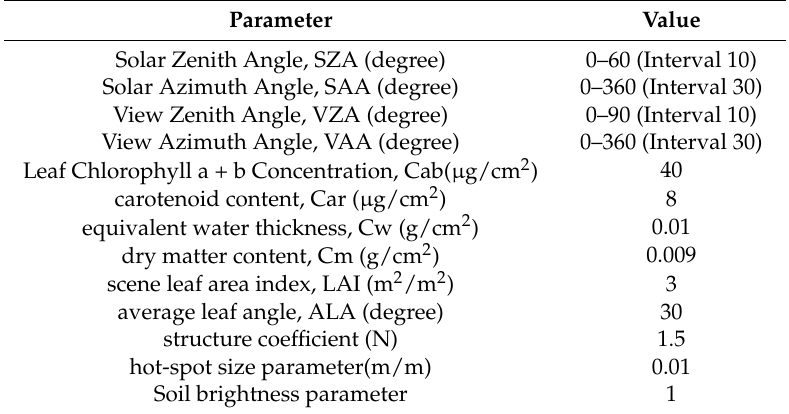
Table 1. The parameters and the values of the PROSAIL model.